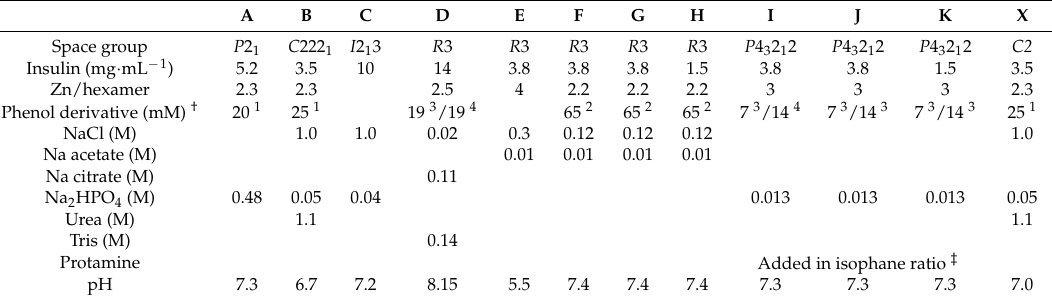
Table 1. Crystallization conditions for the samples used in the